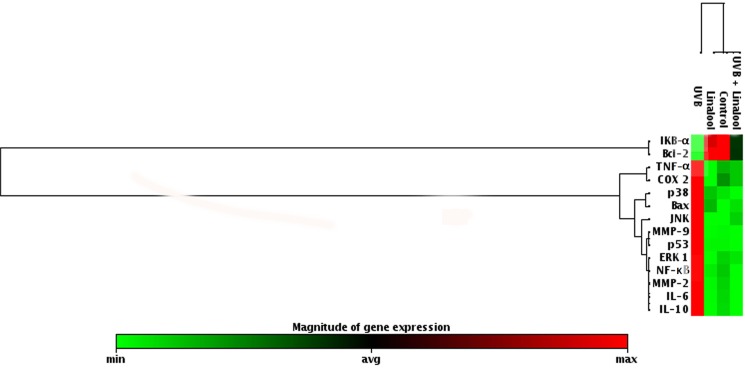
Effect of linalool on UVB-mediated mRNA expression level of oxidative stress marker in HDFa.Cells were treated with linalool following UVB radiation total cellular RNA was isolated and reverse transcribed. The mRNA levels of genes involved in oxidative stress were detected using custom PCR array by following the manufacturer’s instructions. The clustergram results were analyzed by SA Biosciences’ online tool.